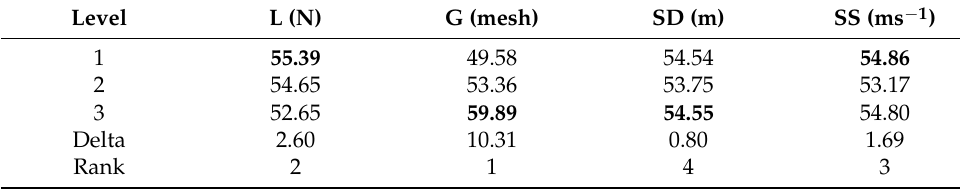
Table 5. Response table for SNRs of V L (smaller is better).